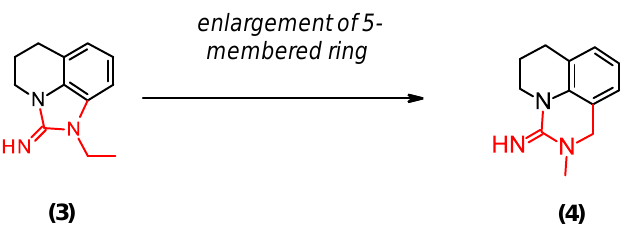
Scheme 6. Rational design of inhibitor ( 4 ) based on X-ray data of inhibitor ( 3 ).